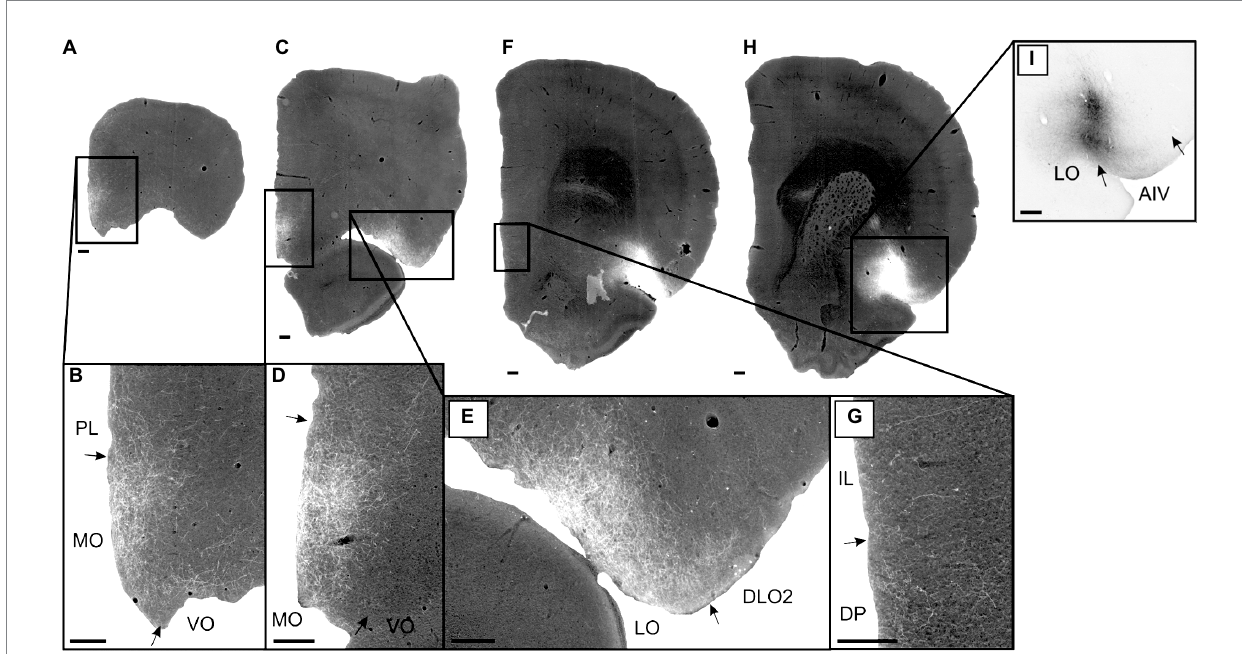
FIGURE 3 Images visualizing the fiber labeling resulting from a BDA injection covering layers 2–5 of the ventral agranular insular field (AIV) in the anterior insular domain (case 14894B). The injection also involved a small portion of the lateral orbital field (LO). (A,B) Low magnification (A) and high-magnification (B) images visualizing the dense fiber labeling in the medial orbital field (MO) at very rostral levels. (C–E) Low magnification (C) and high-magnification (D,E) images visualizing the dense fiber distribution in the medial orbital (D) as well as lateral orbital (E) fields at slightly more caudal levels. (F,G) Low magnification (F) and high-magnification (G) photomicrographs visualizing fiber distribution in the infralimbic (IL) and dorsal peduncular (DP) cortices. (H,I) low-magnification (H) and high-magnification (I) images of the BDA injection site in AIV, showing some LO involvement. Black boxes indicate the areas with zoom images. DLO, dorsolateral orbital field; PL, prelimbic cortex; VO, ventral orbital field. Scale bars equal 250 μ